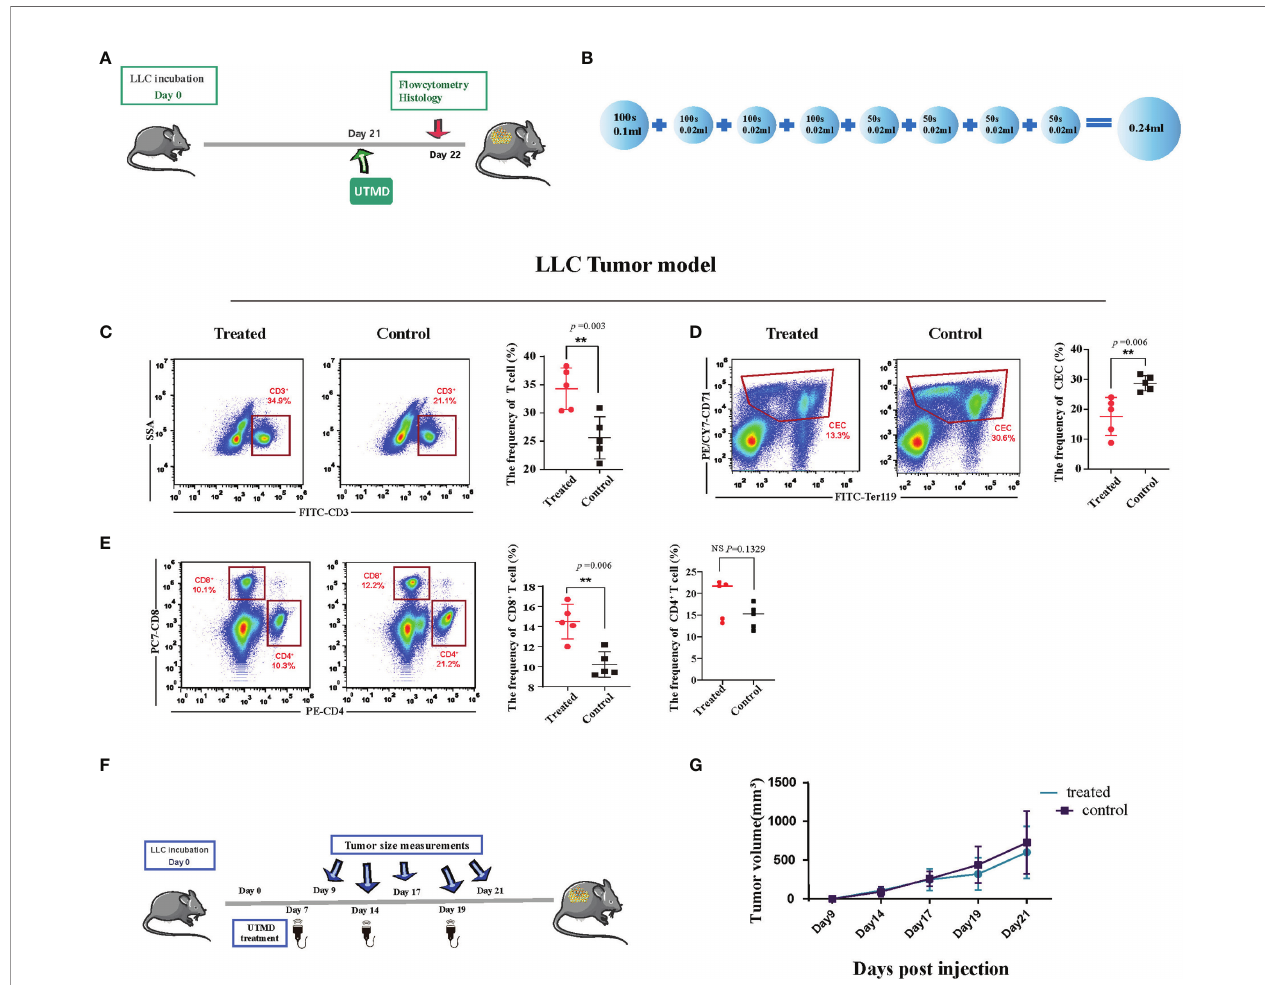
FIGURE 2 | Ultrasound-targeted microbubble destruction (UTMD) alleviates immunosuppression in the late-stage tumor. (A) Timeline of the treatment protocol and group setting. Twenty-one days after incubation, the tumor-bearing mice in the study group received ultrasound treatment. The control group received no treatment. (B) The pattern of microbubble injection. A low dose of microbubble was continuously injected throughout the whole process. The total injected volume of diluted microbubble was 0.24 ml for 600 s. Tumor size measurement and treatment utilization distribution. (C – E) Representative fl ow cytometry dot plots (left) and cumulative composite data (right) of the frequency of T cells, CD8 + T cells and CD4 + T cells, and CD71 + erythroid progenitor cells (CECs) in the spleen of Lewis lung cancer (LLC) tumor-bearing mice. Each point represents data from an individual mouse (n = 5). (F) The time-point distribution of multiple treatments and tumor measurements. (G) The curve line of tumor growth after ultrasound treatments (n = 8). There is no signi fi cant difference in tumor volume at the start point between the two groups. The tumor growth curve also showed no difference. **P < 0.01, NS, no signi fi